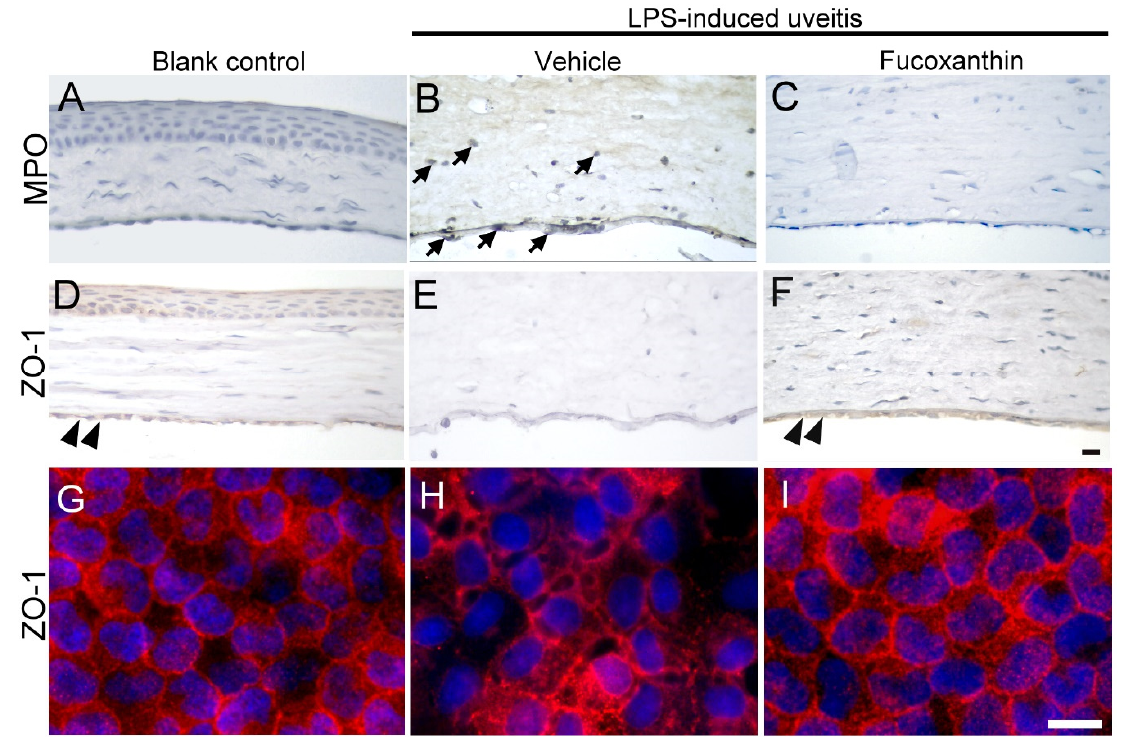
Figure 6. Effects of fucoxanthin on the infiltration of LPS-induced MPO-positive cells and disruption of ZO-1 in the corneal endothelium of the anterior chamber. MPO ( A – C ) and ZO-1 ( D – I ) expression levels among the blank control ( A , D , G ), LPS/vehicle ( B , E , H ), and LPS/10 mg/kg fucoxanthin ( C , F , I ) groups. Immunohistochemical staining showed strong adherent effects and infiltration of MPO-positive inflammatory cells (arrows) in the LPS/vehicle group ( B ) relative to equivalent measurements in the control group ( A ). In contrast, there were decreased numbers of MPO-positive inflammatory cells in the anterior chamber in the fucoxanthin/LPS group ( C ). Moreover, histological examination showed a continuous brown stained ZO-1 in the region of cell–cell contact in the corneal endothelium of the blank control (double arrowheads, ( D )). Disruption of ZO-1 was observed in the LPS/vehicle group ( E ) relative to in the control group. Compared to the LPS group ( E ), an increase in the intensity of browning staining ZO-1 expression at the cell–cell junction was noted in the LPS/fucoxanthin group (double arrowheads, ( F )). On whole flat-mounted corneas, disruption of tight junction was prevented in the LPS/10 mg/kg fucoxanthin group ( G – I ). Nuclei were stained with hematoxylin or DAPI. Scale bars = 20 µ